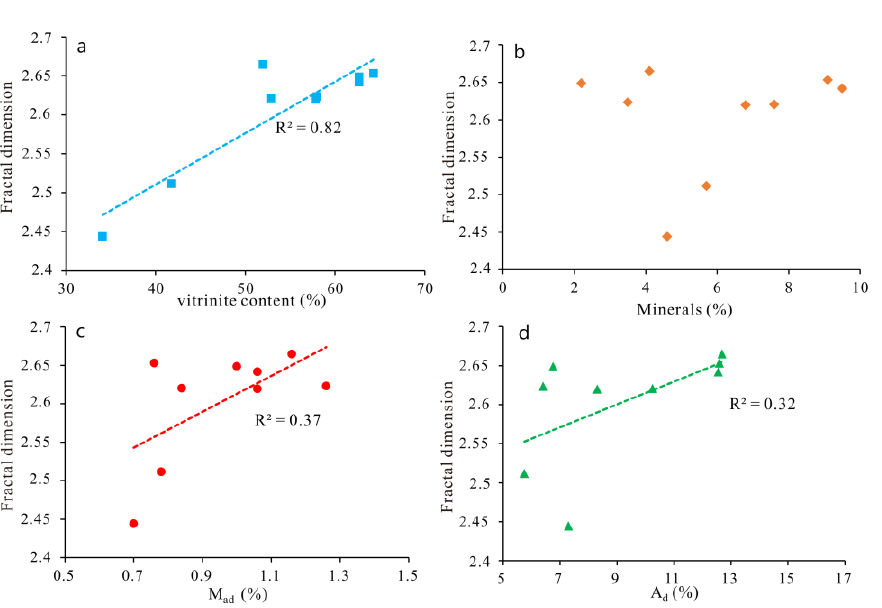
Figure 13. Relationship between the micropore fractal dimension and vitrinite content ( a ), and minerals ( b ), d M ad ( c ) and A d ( d ).